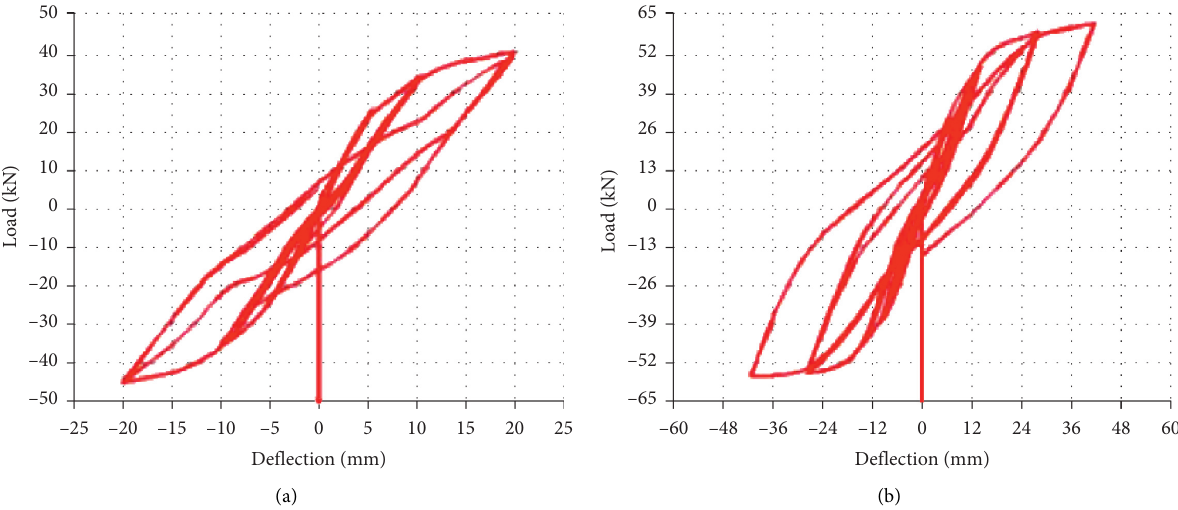
Figure 5: Comparison of the hysteretic curves of model 1 (analysis results): (a) before reinforcement; (b) after